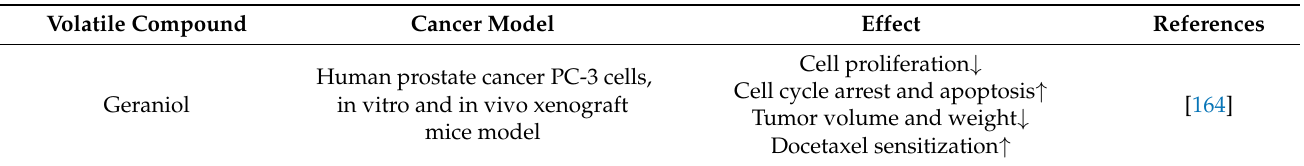
Table 3. The effect of volatile compounds rich in berries on cancer